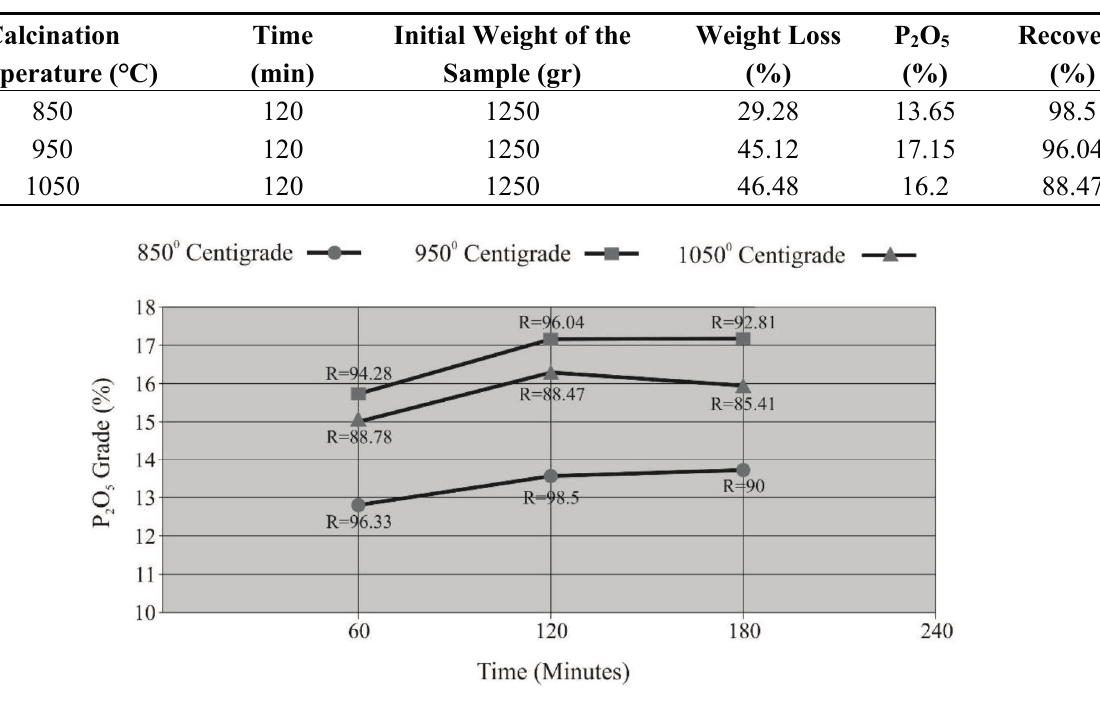
Figure 4. The effect of time and temperature on the grade and recovery (R) of P 2 O 5 for the 0.15–2.4-mm